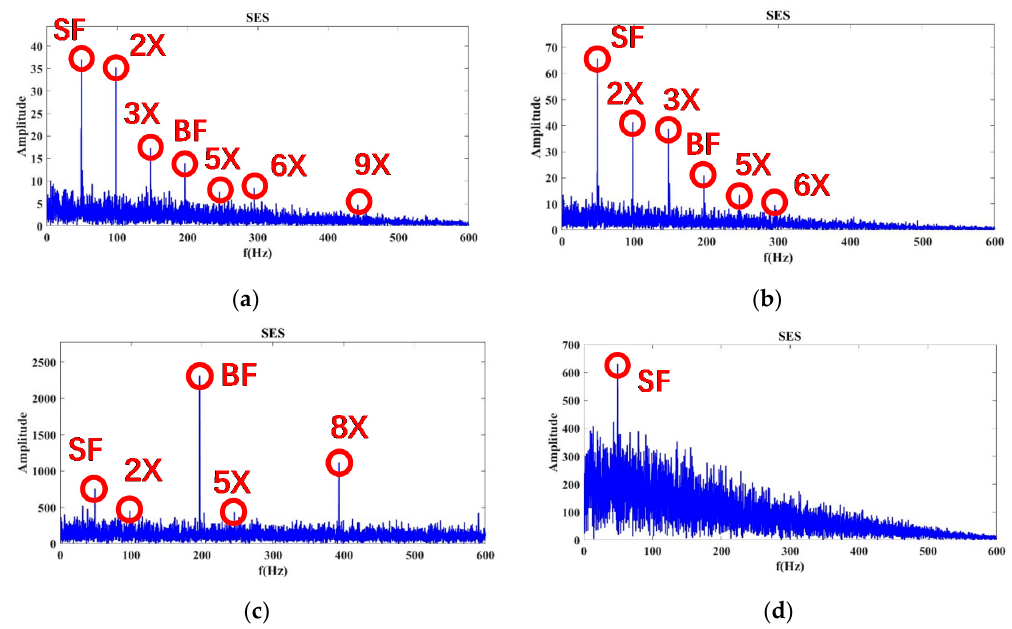
Figure 9. Results of the SES spectrum of the Autogram at an 80% flow rate at Sensor 15: ( a ) Status 1: No cavitation; ( b ) Status 8: Incipient cavitation; ( c ) Status 9: Incipient cavitation; ( d ) Status 10: Severe